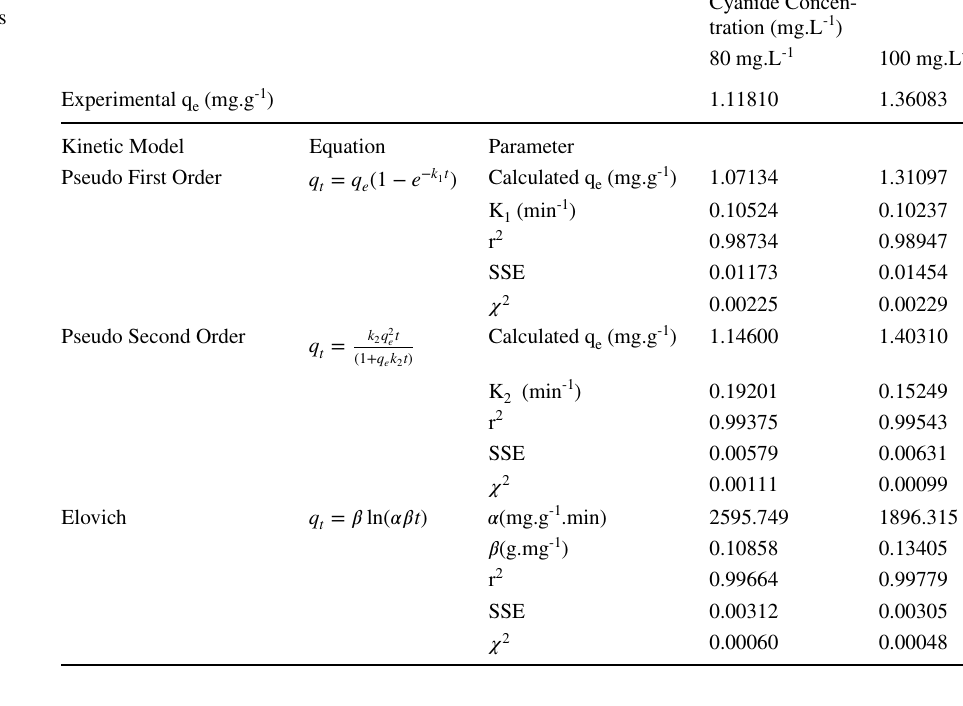
Cyanide Concen- tration (mg.L -1 )